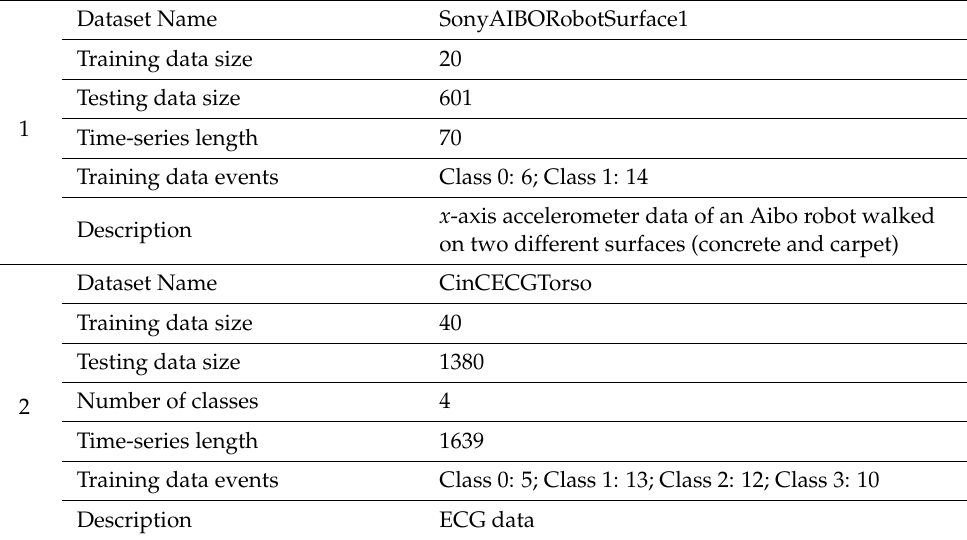
Table 1. Data from the UCR time-series classification archive used in the experiments.